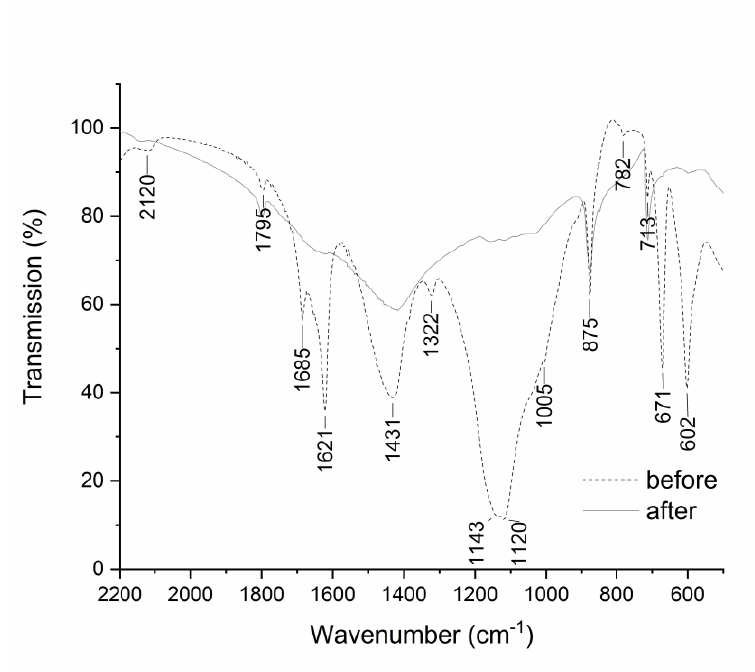
FIGURE 4: FTIR transmittance analysis of a repre- sentative area of fragment B before (dotted line) and after (solid line) the biocleaning. The spec- trum recorded before the treatment (dotted line), shows the signals of calcium carbonate (1795, 1431, 875, 713 cm -1 ), gypsum (1685, 1621, 1143, 1120, 671, 602 cm -1 ) and calcium oxalate (1322, 782 cm -1